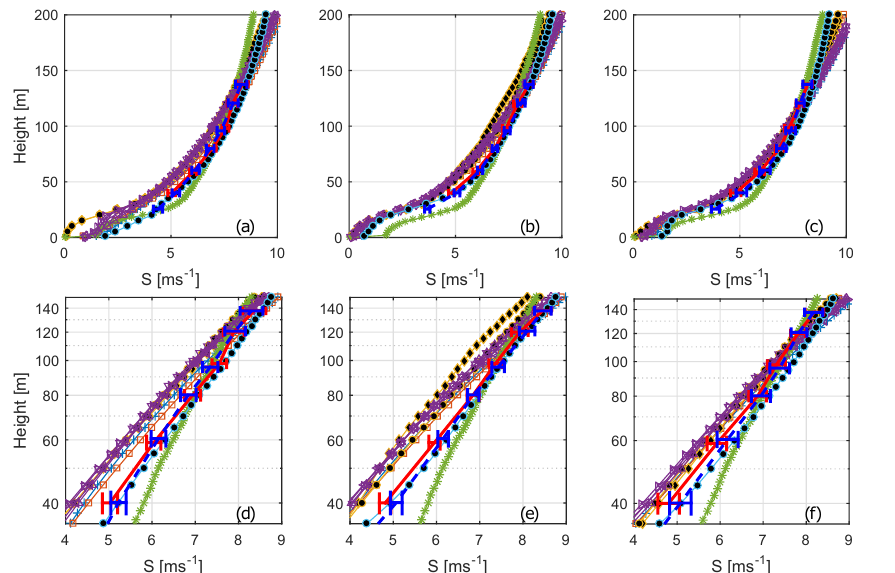
Figure 3. Wind speed profiles.The blue dashed line shows the average from the cups, and the red full line shows the average from the sonics. Error bars indicate the 95% confidence level for the mean value. The various other markers indicate simulated wind speeds. Please see Table 1 for a legend of marker representations. LES models have been given black filling in order to increase readability. (a, d) Results from 100 ◦ , (b, e) from 240 ◦ , and (c, f) from 290 ◦ . (d–f) are zoomed in and in plotted in log space to improve